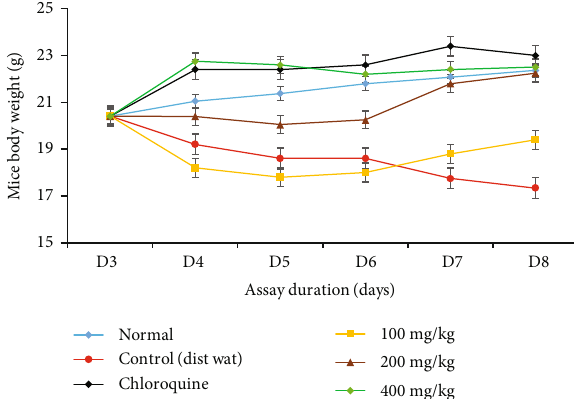
Figure 4: Evolution of body weight of infected mice during the treatment with Tm sb w